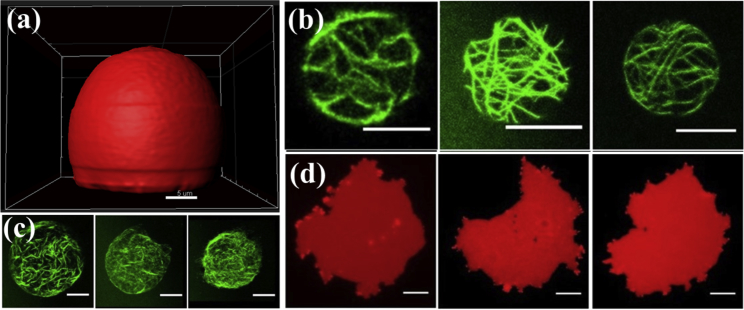
(a) The spherical cap shape adopted by the cortex-free vesicle under strong adhesion. The membrane was labeled with Texas Red to visualize the membrane for confocal scanning. The scale bar represents 5 μm. (b) The bottom-most slice from the z-stacks of three different active vesicles that did not burst even after 30 min of contact with the functionalized glass surface. (c) A collapsed actin structure of three different active vesicles that burst on the surface after making contact. Scale bars, 10 μm. (d) Three different active vesicles that bursted, showing the formation of supported bilayer with an irregular shape on the surface. The membrane was labeled with Texas Red. The scale bar represents 10 μm. To see this figure in color, go online.